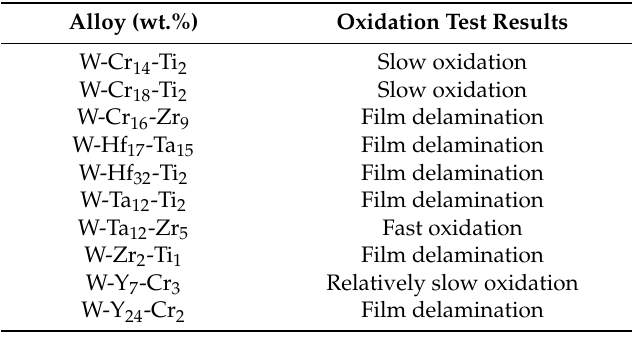
Table 1. Composition and results of the screening oxidation tests with different tungsten-based alloys at 1073 K for 3 h. [69].